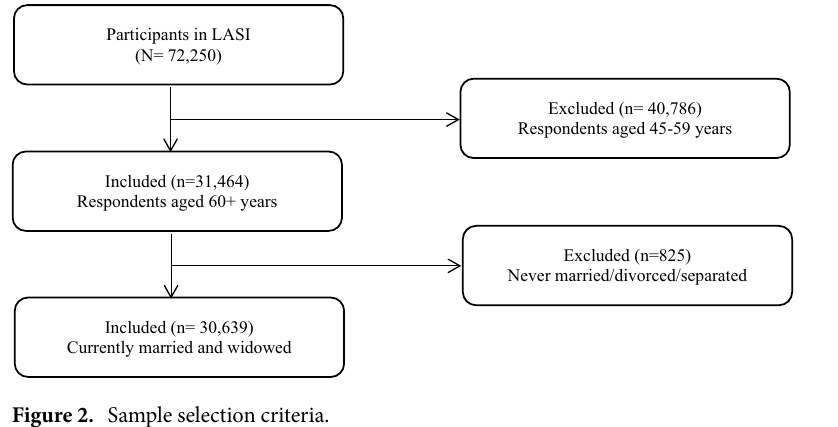
Figure 2. Sample selection